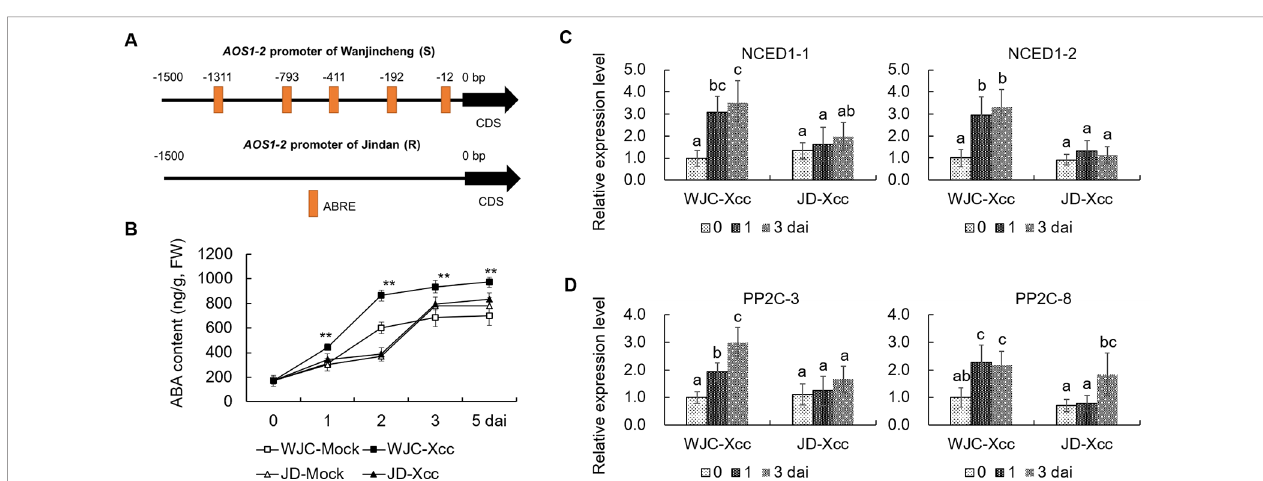
FIGURE 7 | ABA was induced in Wanjincheng orange after infection with Xcc. (A) Cis-regulating motifs in the 1.5-kb promoters of AOS1-2 genes analyzed using PlantCARE (http://bioinformatics.psb.ugent.be/webtools/plantcare/html/). (B) ABA content in Wanjincheng orange and Jindan leaves before and after Xcc inoculation. Error bars indicate the SDs of three biological repeats. Statistical signi fi cance related to their own mock control was determined by two-tailed Student ’ s t -test (**, P < 0.01). (C) Expression levels of genes involved in ABA synthesis. (D) Transcriptional levels of genes involved in ABA signal transduction. Fully expanded citrus leaves were injected with 5 × 10 5 -cfu/mL Xcc suspensions, and samples treated with water were used as blank controls. Error bars represent the SDs of three biological replicates. Different letters above bars represent signi fi cant differences from the 0 dai of WJC-Xcc based on Duncan ’ s multiple range test ( P < 0.05). WJC, Wanjincheng orange; JD, Jindan; AOS, 13-allene oxide synthase; ABRE, abscisic acid-responsive element (ACGTG); ABA, abscisic acid; dai, days after inoculation; FW, fresh weight; NCED1, 9-cis-epoxycarotenoid dioxygenase; PP2C, type 2C protein